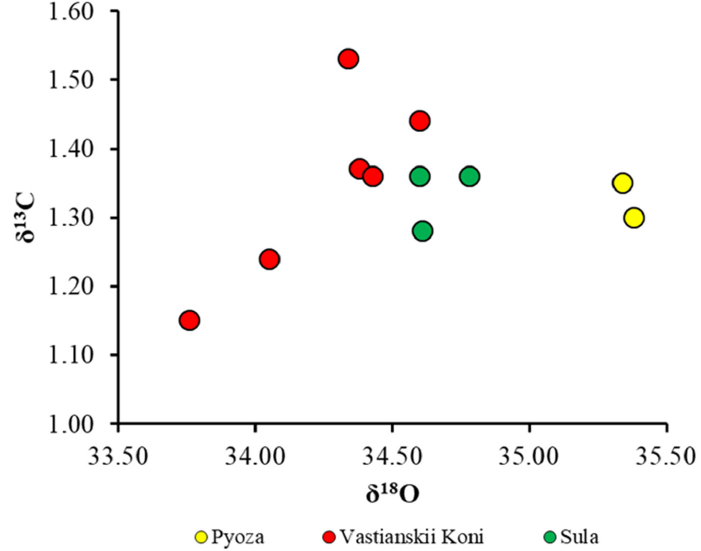
Figure 8. Relationship between δ 13 C and δ 18 O in the studied fossil shells in the sections Peza, Vastyansky Kon’, Sula.